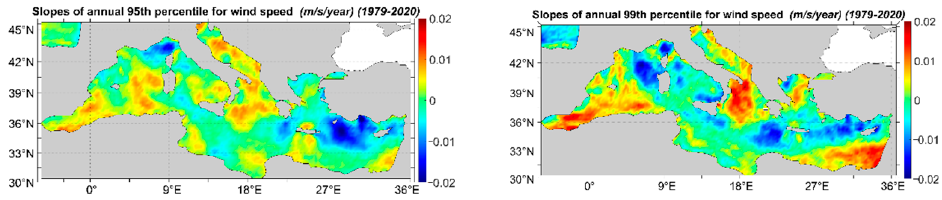
Figure 11. Linear slope of 95th ( left ) and 99th ( right ) annual percentiles of wind speed.